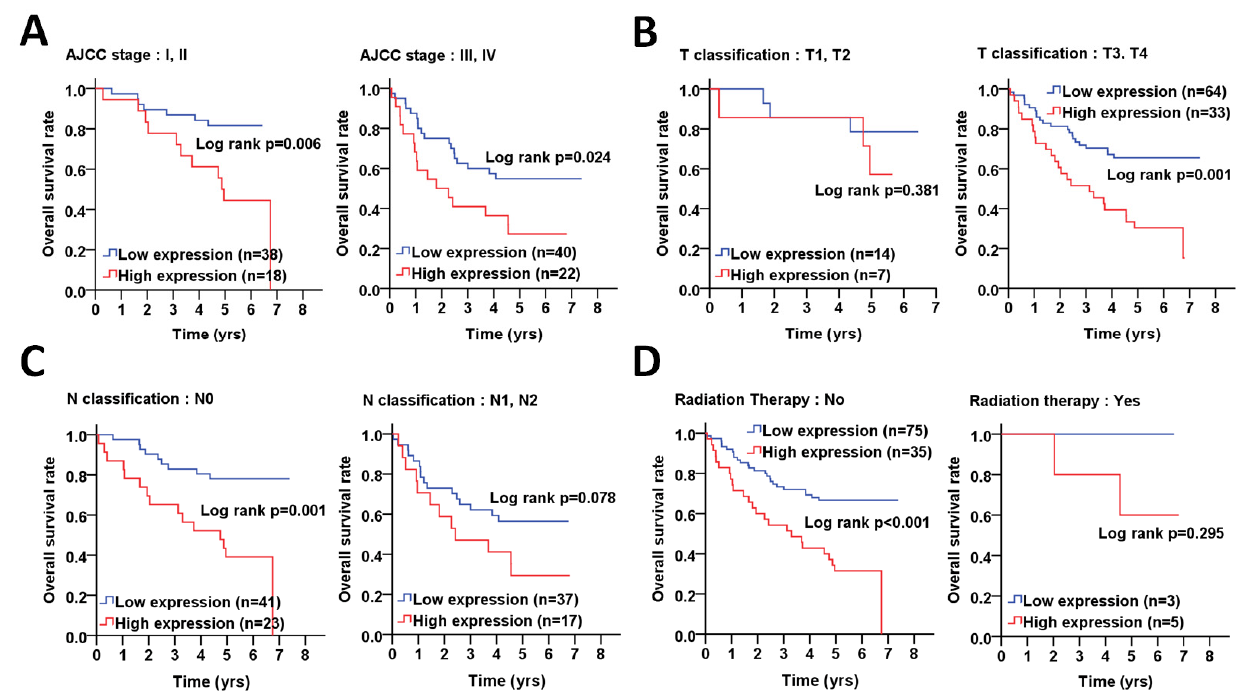
Figure 3. The correlation of ATG5 protein levels with the overall survival in CRC patients with certain pathological stages and radiation therapy. ( A ) The CRC patients were stratified into early and advanced pathological stages, including AJCC, ( B ) tumor size (T stages), ( C ) lymph nodes invasion (N stages), and ( D ) radiation therapy. The association of the ATG5 protein level in tumor tissues with the overall survival was analyzed by Kaplan–Meier plots. The ROC curve was used to determine the cutoff values to differentiate the high (red) or low (low) ATG5 protein levels in tumor tissues. The log rank was used to determine the significance of ATG5 protein levels on the overall survival of CRC patients.